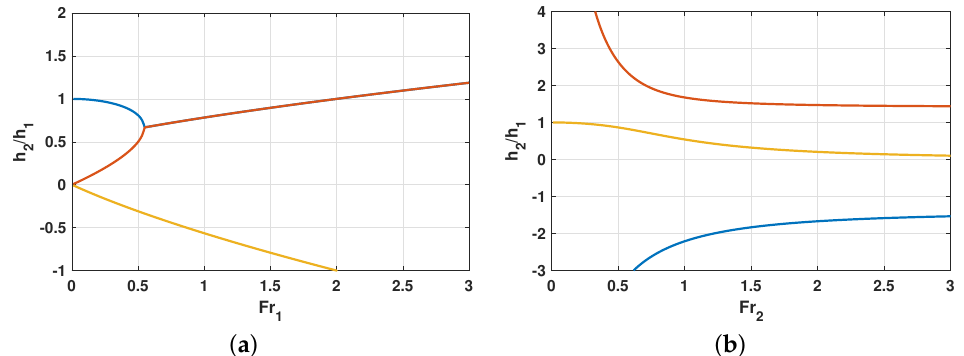
Figure 6. The solution of the flow depth ratio (here with ζ = 1) depends on the velocity for the sudden loss and the Froude number. ( a ) The ratio of flow depths as a function of the upstream Froude number Fr 1 (Equation(10)) yields ambiguous and complex solutions, and is thus incorrect. ( b ) The ratio of the flow depths as a function of the downstream Froude number Fr 2 (Equation(12)) gives ambiguous but real